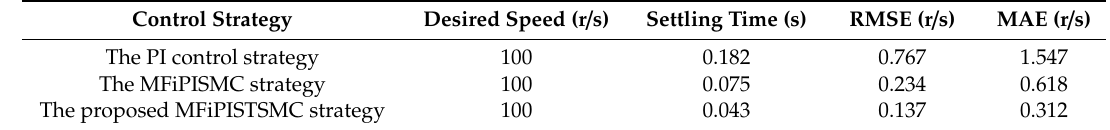
Table 4. The comparative results of the load increased suddenly.